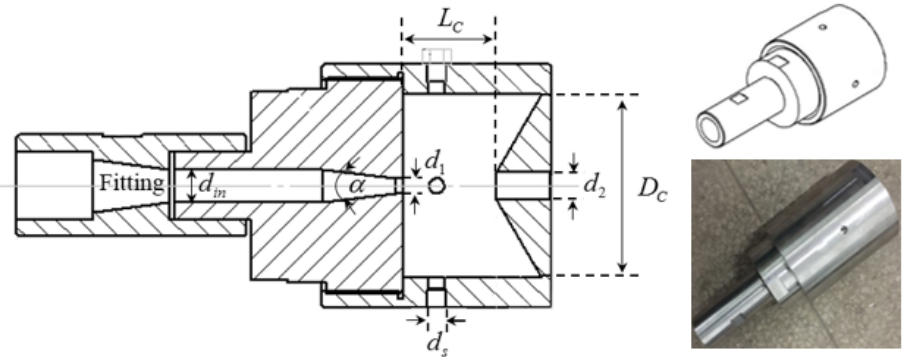
Figure 6. Profiles and photos of the three fittings.